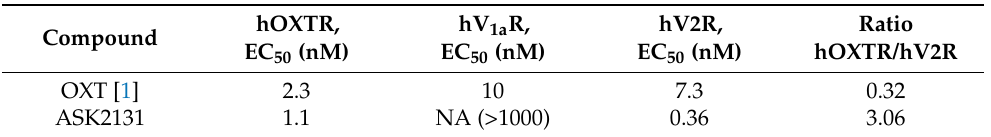
Table 1. Receptor pharmacology profile of both oxytocin (OXT) and ASK2131 against OXTR, human